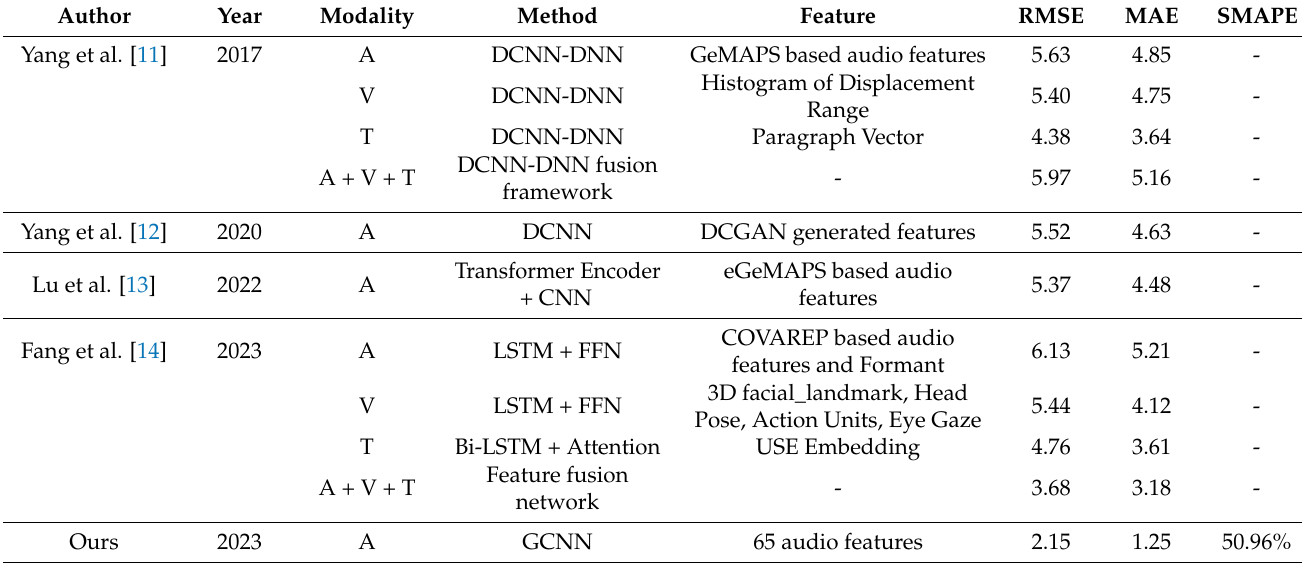
Table 3. Prediction results and comparison with the existing methods.